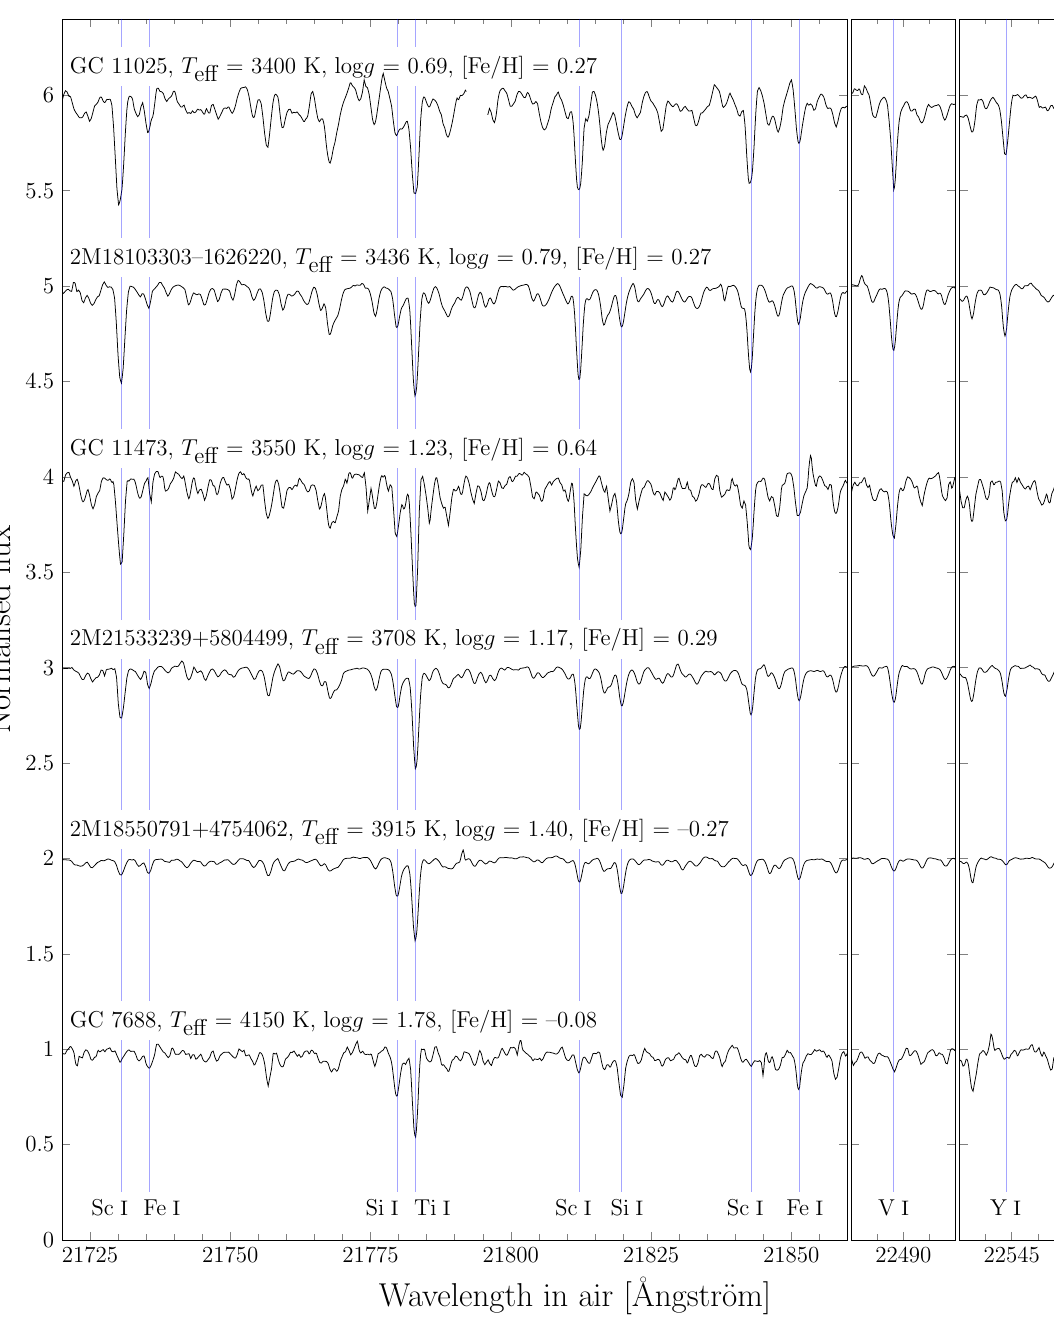
Figure 1. This figure from Thorsbro et al. [6] (their Figure 1) shows that the strong scandium feature seems to be connected to the effective temperature of the star. Six stellar spectra are plotted together with increasing temperature from top to bottom with blue vertical lines identifying lines of interest. The normalized fluxes are translated upward with integer values for presentation. The stars are a mix of three Galactic center stars (GC 7688, GC 11025, and GC 11473) and three solar neighborhood stars (2M18103303–1626220, 2M18550791+4754062, and 2M21533239+5804499). The spectra show strikingly strong scandium, vanadium, and yttrium lines in the cooler stars, even though the stars are located in widely different environments. As temperatures increase to 3900 K and beyond, the neutral lines of scandium, vanadium, and yttrium begin to vanish, presumably due to